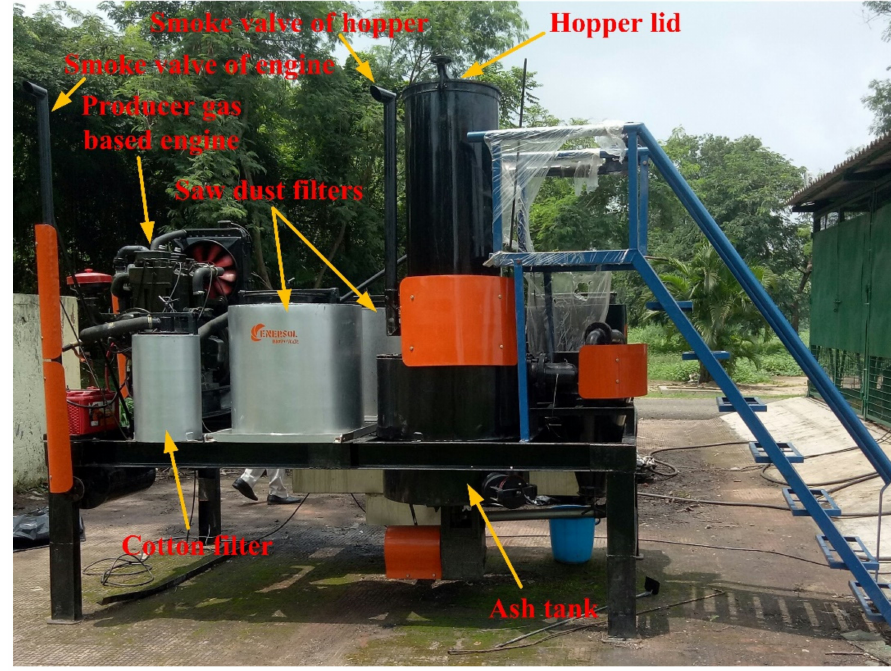
Figure 8. Front view of the biomass generator